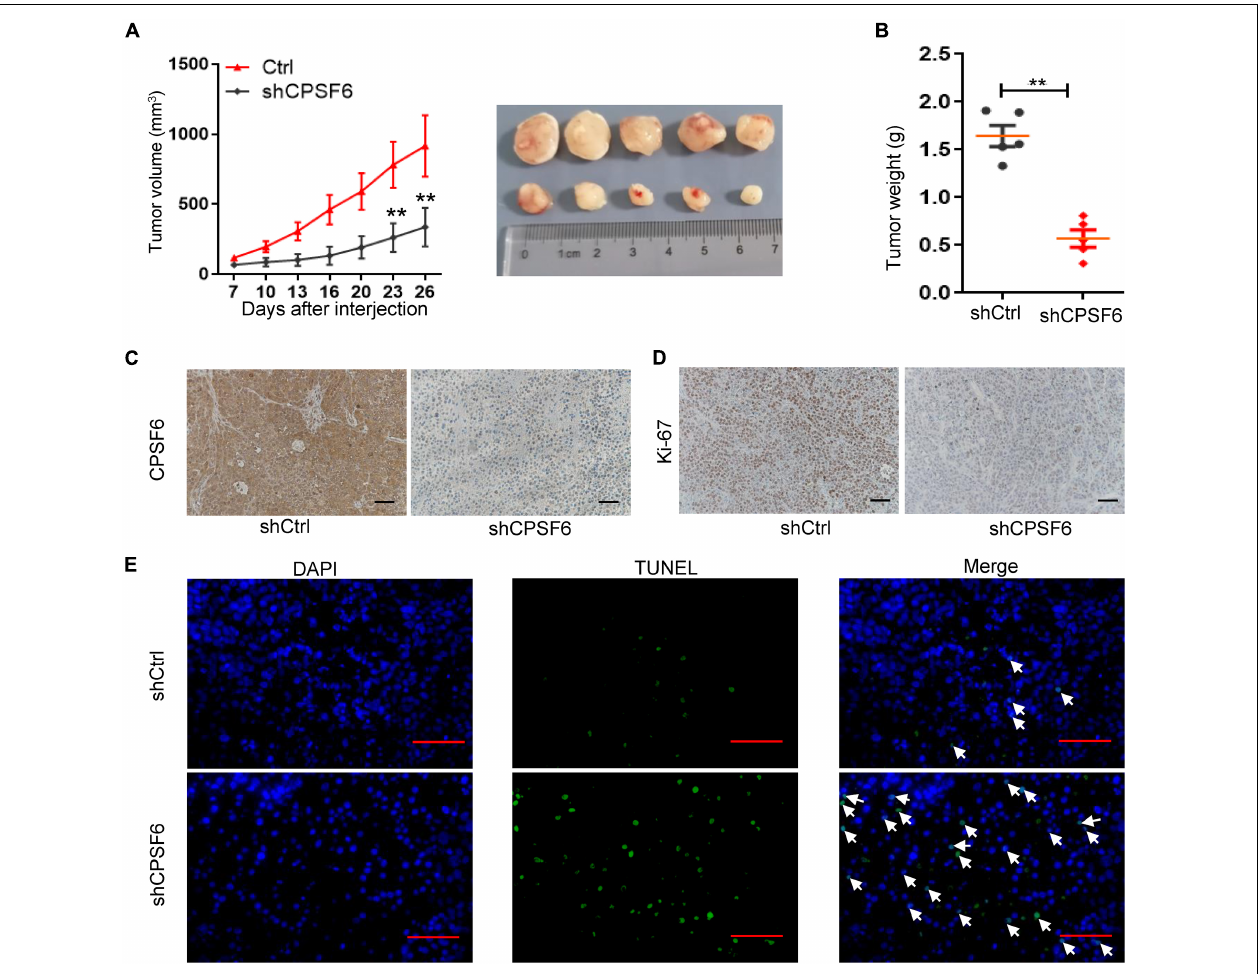
FIGURE 3 | CPSF6 promotes cell growth and inhibits apoptosis in GC cells in vivo . (A,B) Xenograft nude mouse model of tumorigenesis was used to confirm cell growth and weight after knockdown of CPSF6. (C,D) CPSF6 and Ki-67 staining of the respective GC cell–derived tumor sections (scale bar: 100 µ m). (E) TUNEL assay of the respective GC cell–derived tumor sections (scale bar: 100 µ m). The white arrows represent apoptotic cells. (**0.001 < p <